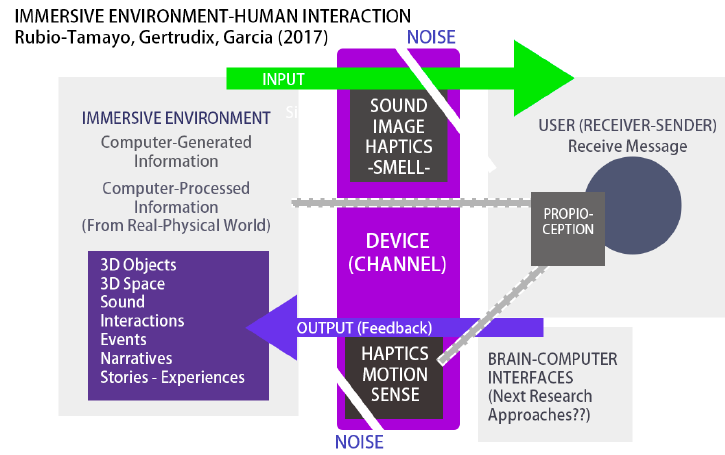
Figure 3. Virtual reality and immersive environments also have, in short-term applications to diverse research domains, an essential role to represent components and ideas related, for example, to the scientific domain. In the figure, a model schema describes the relationship between immersive environments (and VR) and human senses, based on literature reviews. A deep knowledge of human senses, as well as a development of new user interfaces (as brain-computer interfaces), would help contribute to developing more effective immersive experiences and VR environments. The potential of VR and immersive environments to develop and integrate symbolic and abstract representations may lead researchers in the aforementioned disciplines to imagine a wide range of experiences with the mediation of innovative interfaces. This complexity in relationships between factors is also related to the aforementioned ASA reality, a wider concept used to describe a reality being artificial (computer generated), simulated (not integrated in the physical world) and alternate (separated from physical